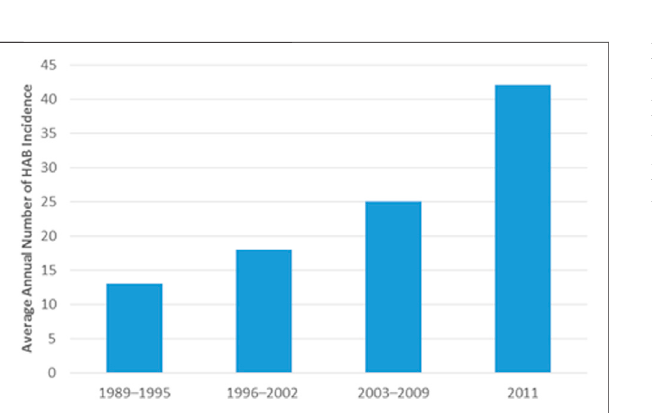
Frontiers in Environmental Science |